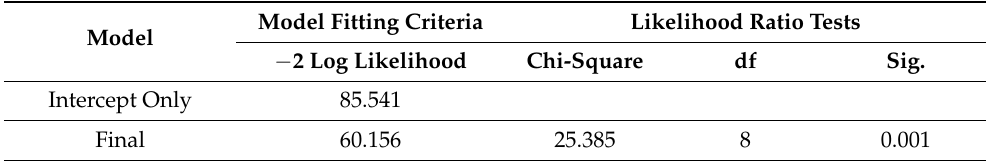
Table 6. Multinomial logistic regression analysis for the LEPR Gln223Arg genotypes. Model Fitting Information.